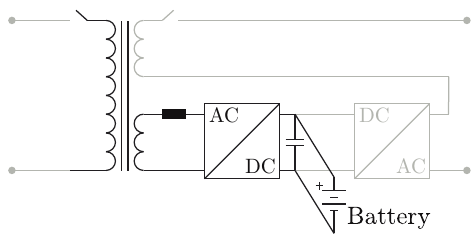
Figure 20. HDT configuration for inrush current